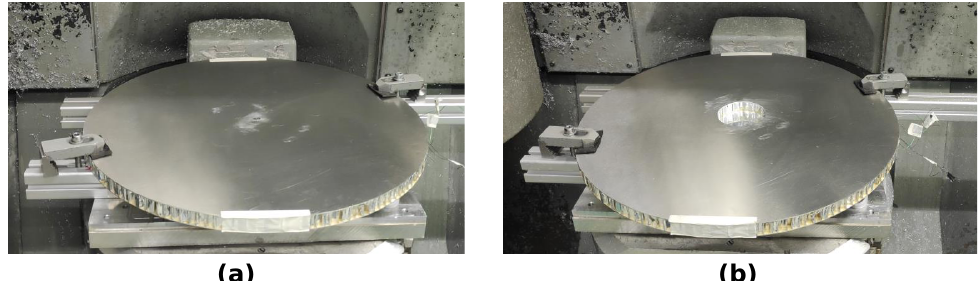
Figure 5. Circular sandwich plate clamped in the milling machine, with a debonding of the radius of ( a ) 2.5mm, and ( b ) 40mm.